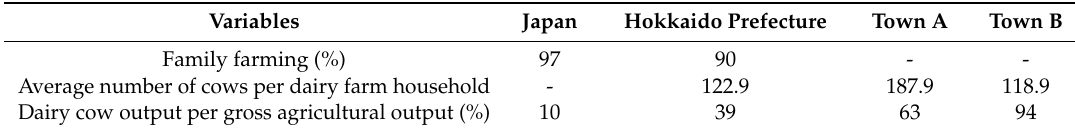
Table 1. Description of the study